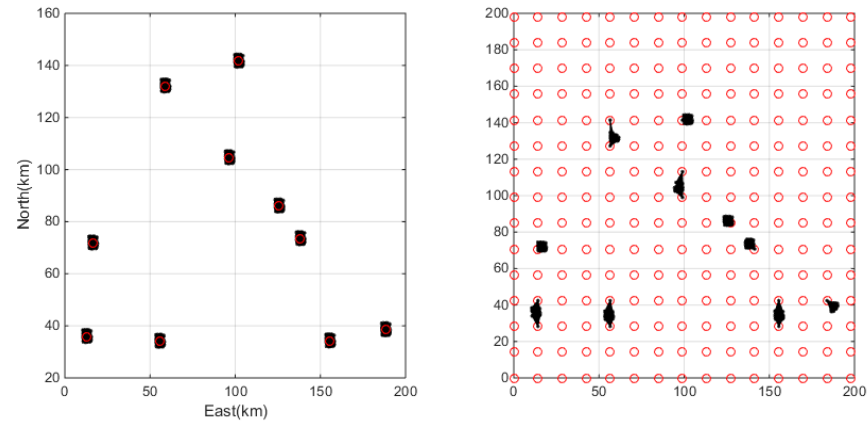
Figure 8. Clustering results with the SOSC ( left ) and grid ( right ) approaches for the clustered distribution case.